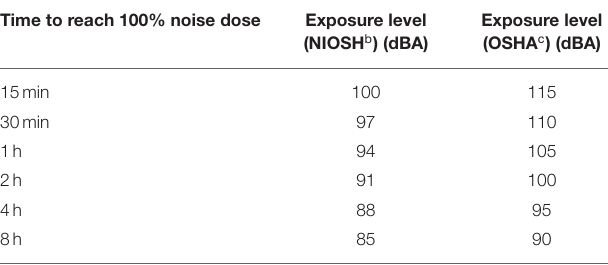
TABLE 1 | Current noise exposure guidelines a